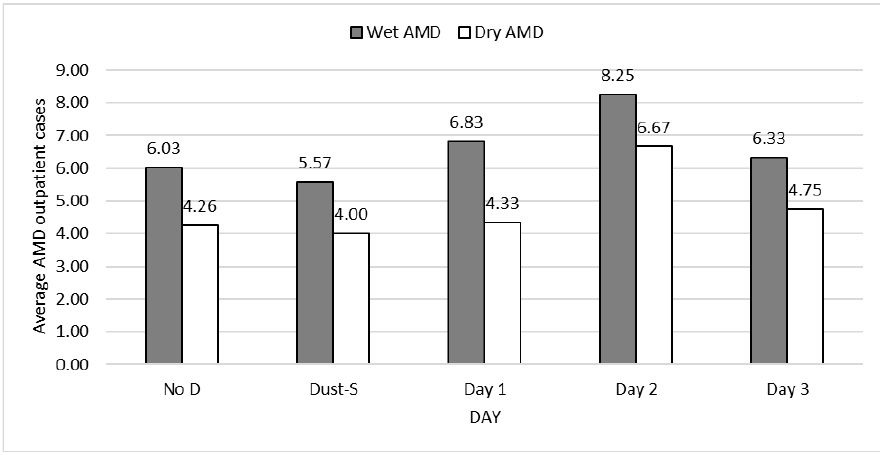
Figure 1. Average daily AMD outpatient visits according to days after dust storms, Taiwan, 2008–2012.